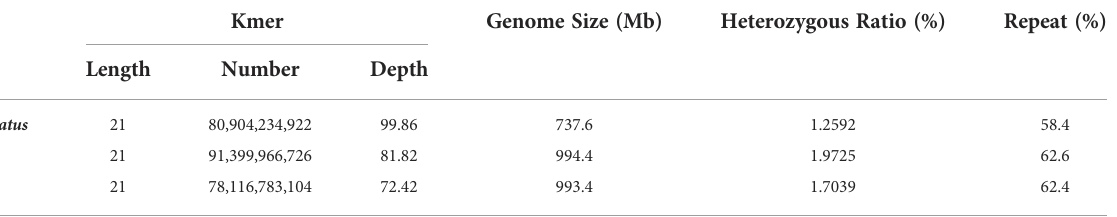
TABLE 2 K-mer statistics and genome estimates of three crab species.